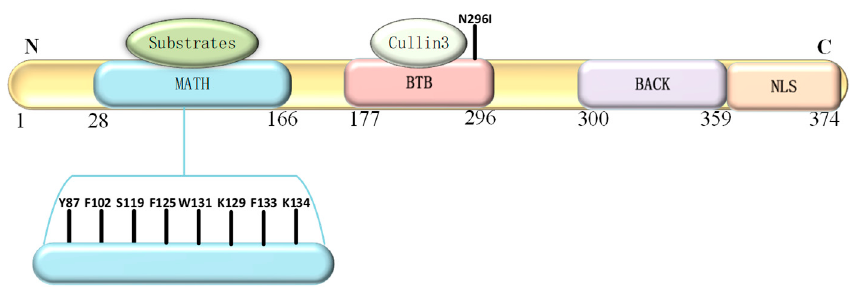
Figure 1. Illustration of the structural features of Speckle-type POZ (pox virus and zinc finger protein) protein (SPOP). The modular structural arrangement of SPOP is shown, which includes the N-terminal meprin and TRAF homology (MATH) domain that selectively recognizes and recruits substrates. Somatic mutations are predominantly clustered in several key amino acids in the N-terminal MATH domain, including Y87, F102, S119, F125, K129, W131, F133 and K134. The Bric-a-brac-Tramtrack/Broad (BTB) domain is responsible for binding to cullin3 and SPOP dimerization, which also involves the BACK domain. The nuclear localization signal (NLS) is a C-terminal nuclear localization sequence.